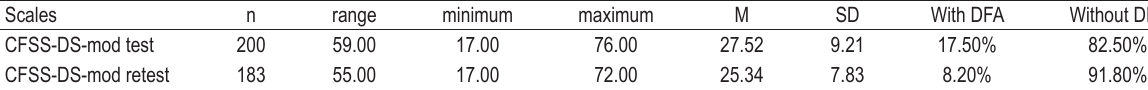
TABLE 5. Descriptive values of test and retest results on the CFSS‑DS‑mode scale Scales n